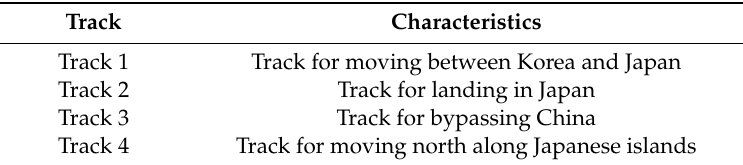
Table 1. Classification of typhoons by track.